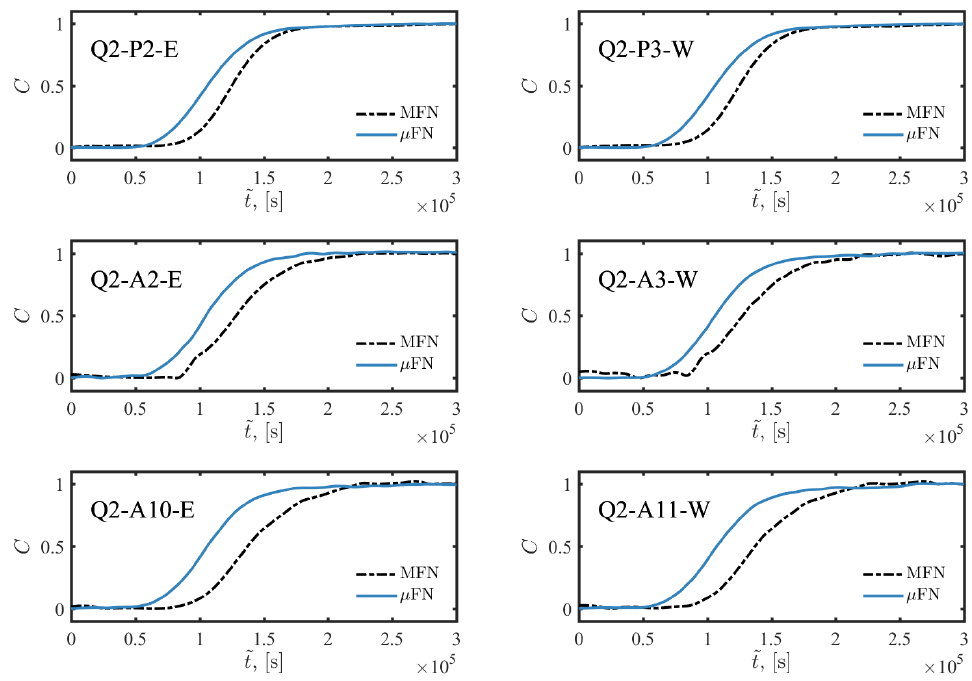
Figure A7. Breakthrough curves measured in physical time in the MFN (dashed line) and µ FN (solid line) at upstream (east) and downstream (west) locations on the same primary (P2–P3), secondary (A10–A11) and tertiary (A2–A3) fracture at Q = 2 µ